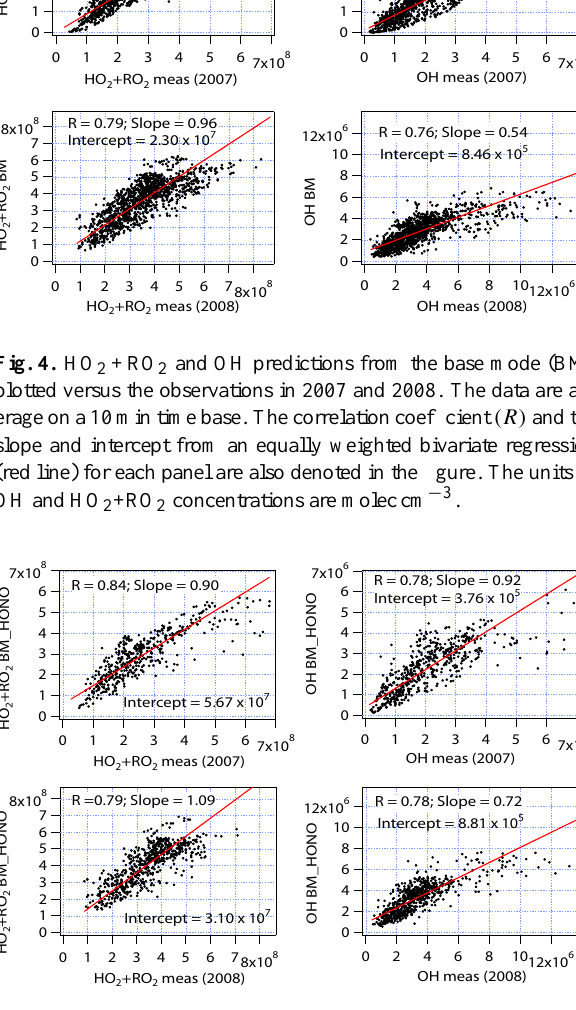
Fig. 5. HO 2 +RO 2 and OH predictions from the base model con- strained to HONO measurements (BM HONO) plotted versus the observations in 2007 and 2008. The data are average on a 10min time base. The correlation coefficient (R) and the slope and in- tercept from an equally weighted bivariate regression (red line) for each panel are also denoted in the figure. The units of OH and HO 2 +RO 2 concentrations are moleccm − 3